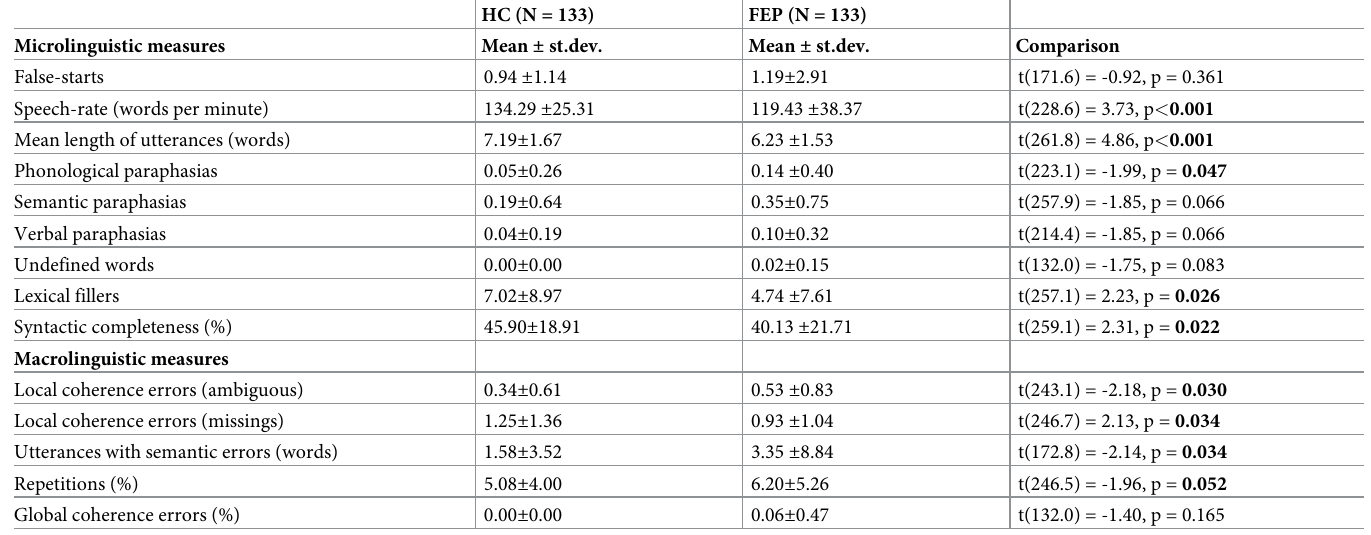
Table 2. Linguistic variables in HC and